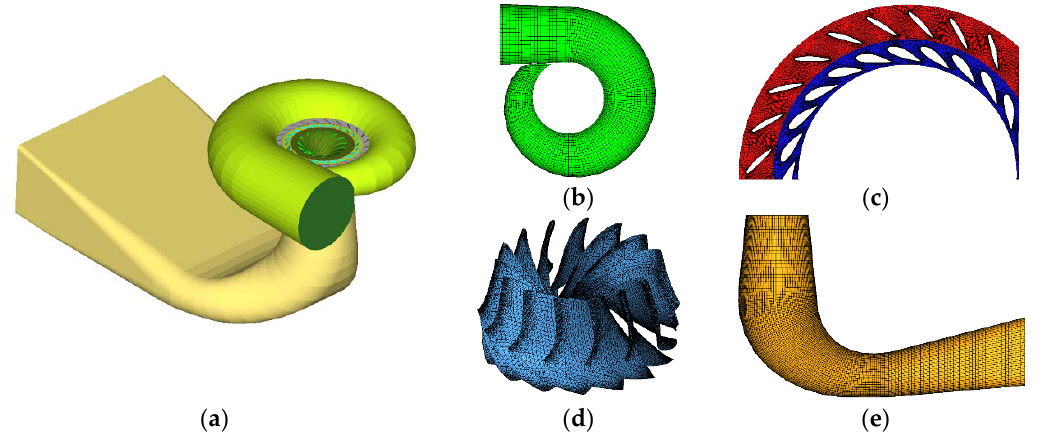
Figure 1. Geometry and mesh in the current simulation for ( a ) total, ( b ) spiral case, ( c ) tandem cascade, ( d ) blade, and ( e ) draft tube.